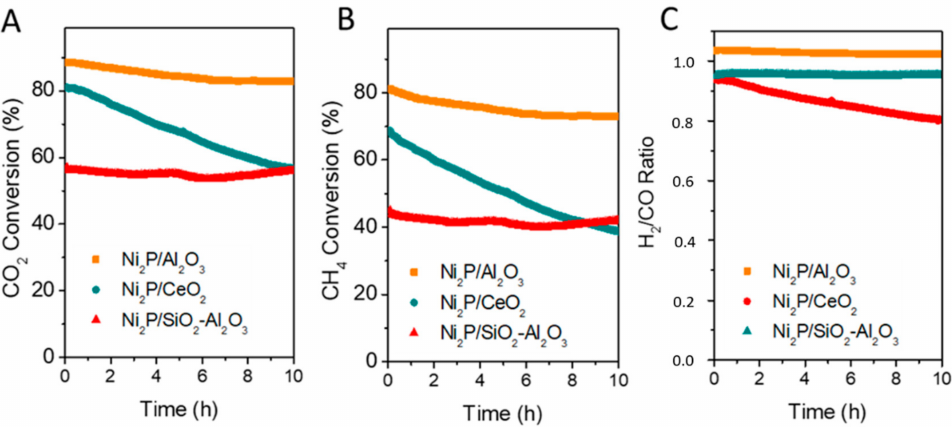
Figure 4. Catalytic performance exhibited by the catalysts’ series at 30 L/g · h and feed composition N 2 /CO 2 /CH 4 —50/25/25. ( A ) CO 2 conversion; ( B ) CH 4 conversion and ( C ) H 2 /CO ratio.